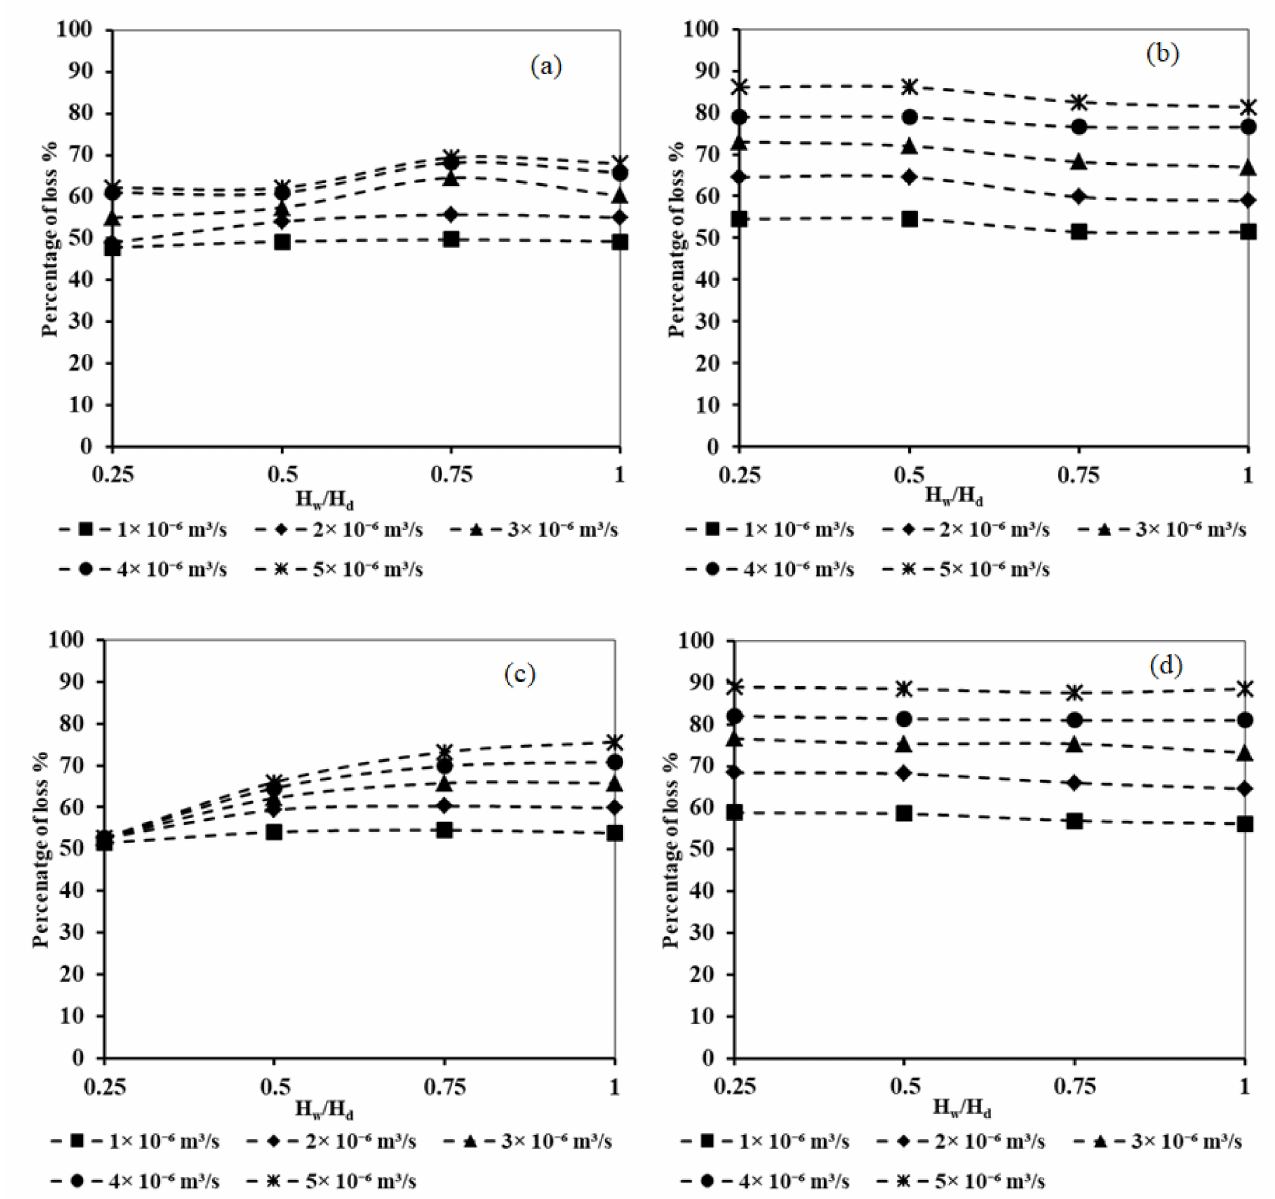
Figure 9. Relation between well location ratio and loss of subsurface dam effectiveness for L d = 0.30 m and H f = 0.1 m for: ( a ) L w /L d = 1.0 and D F = 0.005 m, ( b ) L w /L d = 2.0 and D F = 0.005 m, ( c ) L w /L d = 1.0 and D F = 0.01 m, ( d ) L w /L d = 2.0 and D F = 0.01